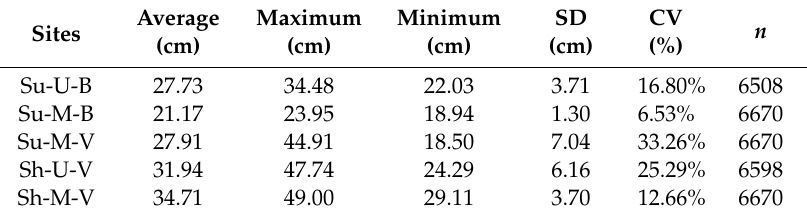
Figure 4. Frequency distribution of soil water storage in the five experimental sites. Table 4. Statistic values of slope soil water storage in the collapsing gully slope.